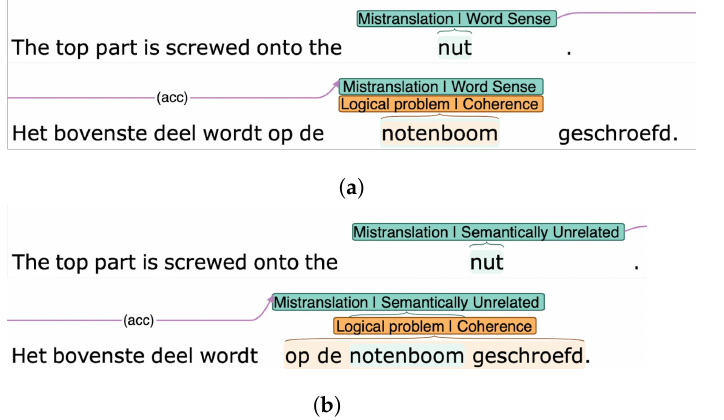
Figure 3. Annotations obtained from ( a ) annotator 1 and ( b ) annotator 2 for the same source sentence ( top ) and the baseline NMT output ( bottom ). “Notenboom” would be the Dutch translation of “walnut tree”; “nut” was correctly translated by the NFR system as “moer”.